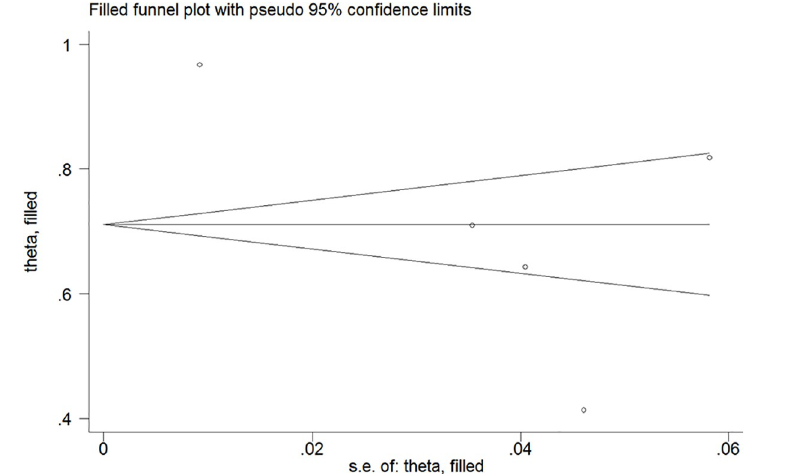
Fig 5. Filled funnel plot of diazoxide responsiveness using the trim-and-fill